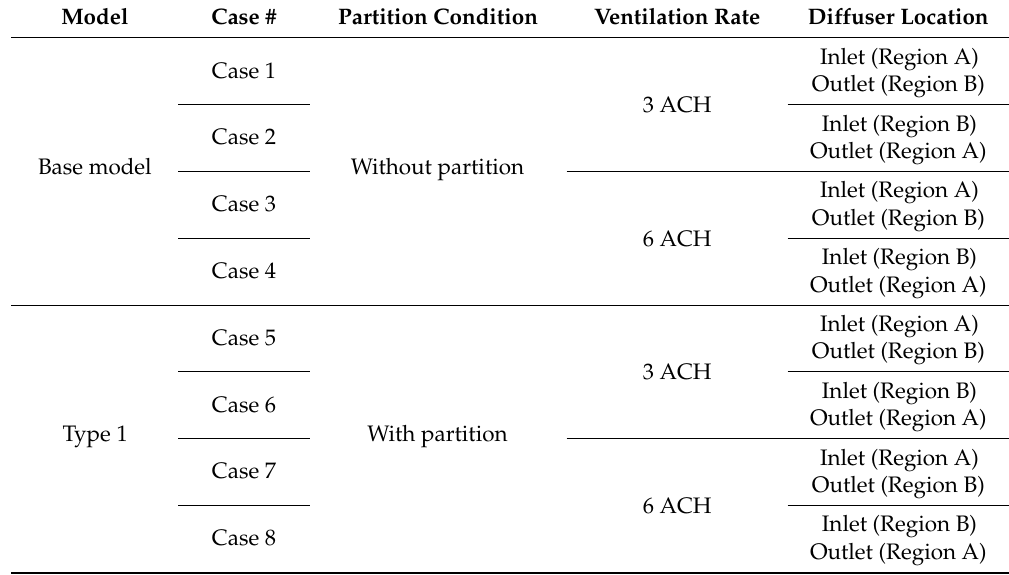
Table 3. Simulation